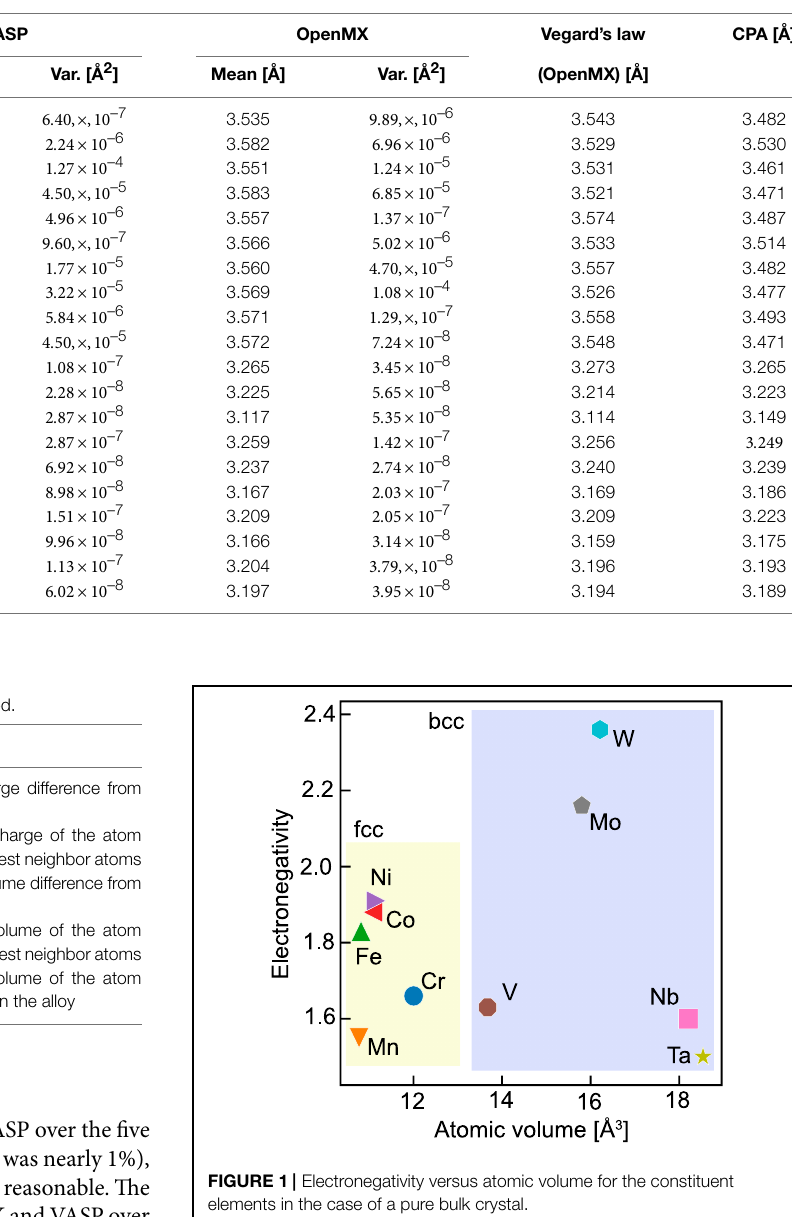
TABLE 2 | Lattice constants in angstroms for the fcc and bcc random alloys, obtained from VASP and OpenMX. The listed means and variances were obtained in calculations on five SQS structures. For reference, the table also lists lattice constants that were estimated by Vegard’s law from their bulk values and obtained from AkaiKKR with the coherent potential approximation (CPA).